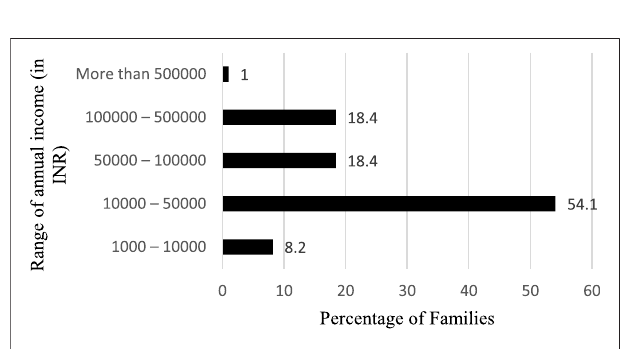
FIGURE 2 | Income of families of individuals interviewed.